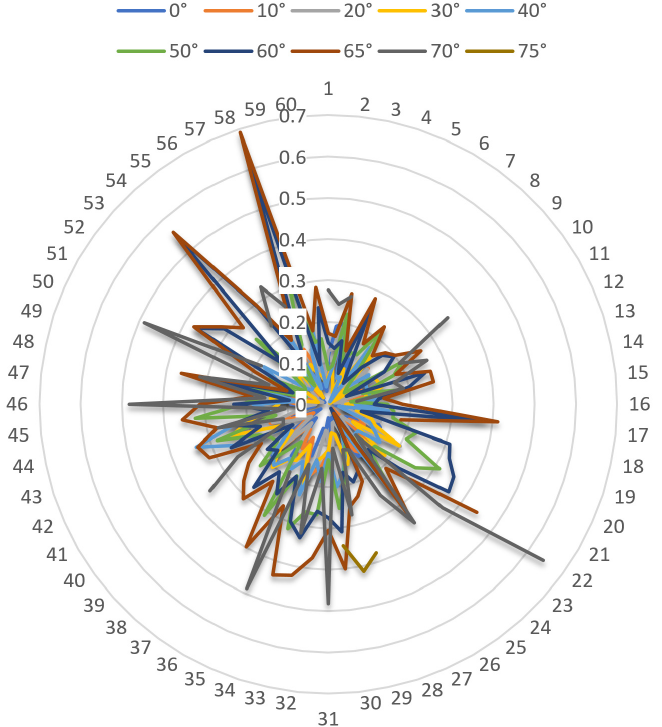
Figure 12. The positioning bias of decoding points with increasing steps of viewing angle.